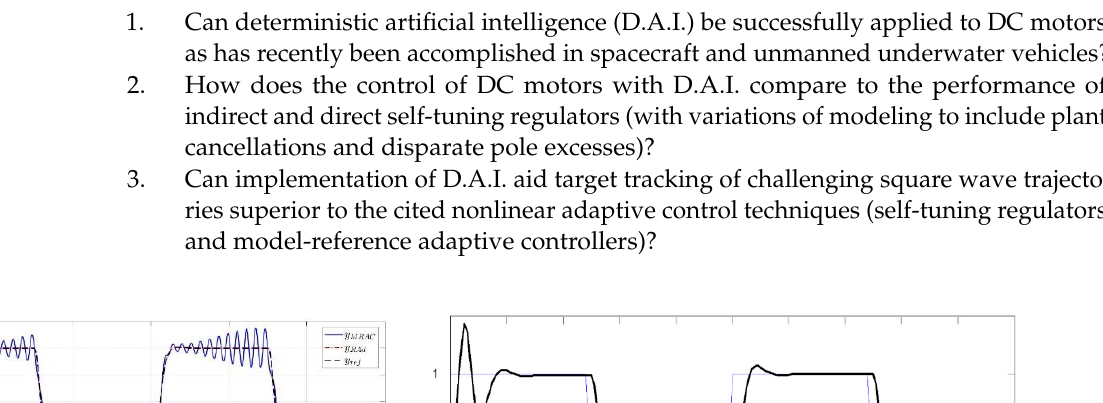
Figure 1. Contextual preface: model-reference and self-tuning regulator adaptive controllers following square waves. ( a ) Context: model-reference adaptive control in [31] following a (sloped) square wave. ( b ) Context: indirect self-tuning reg- ulator in [11] following a (sloped) square wave.